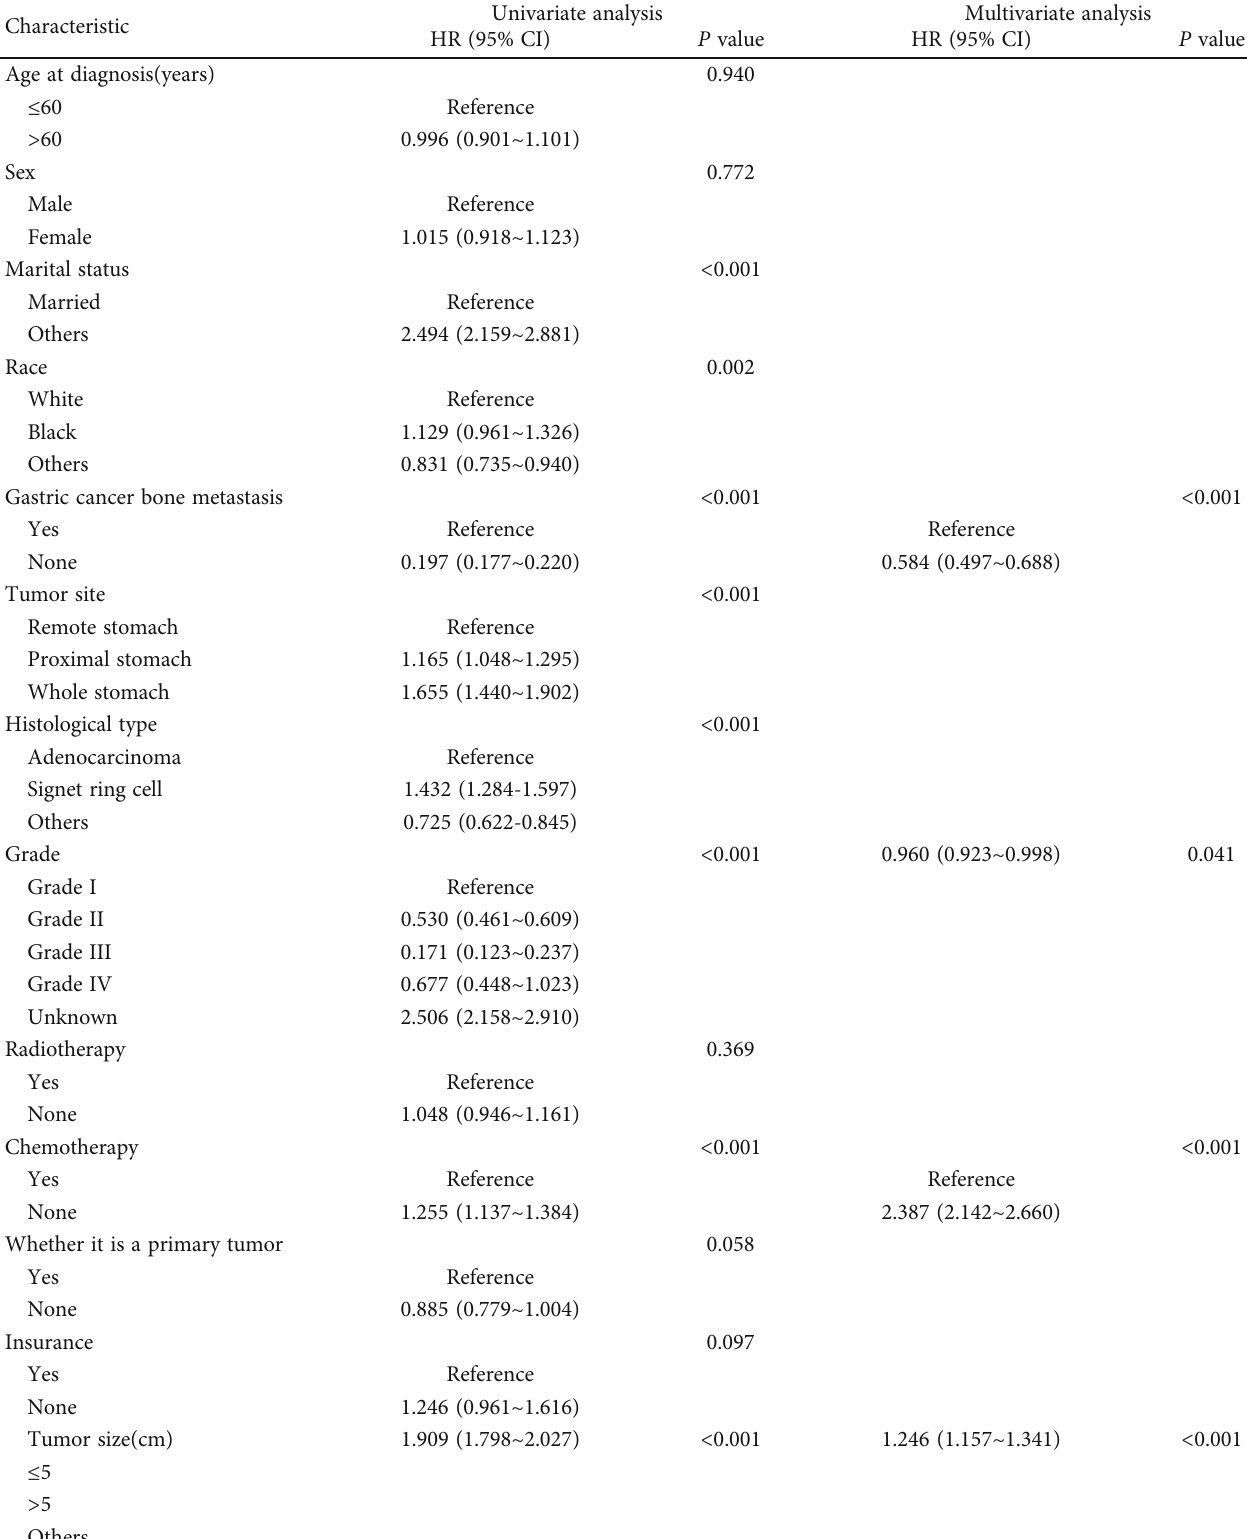
Table 4: Cox univariate and multivariate analysis of gastric cancer